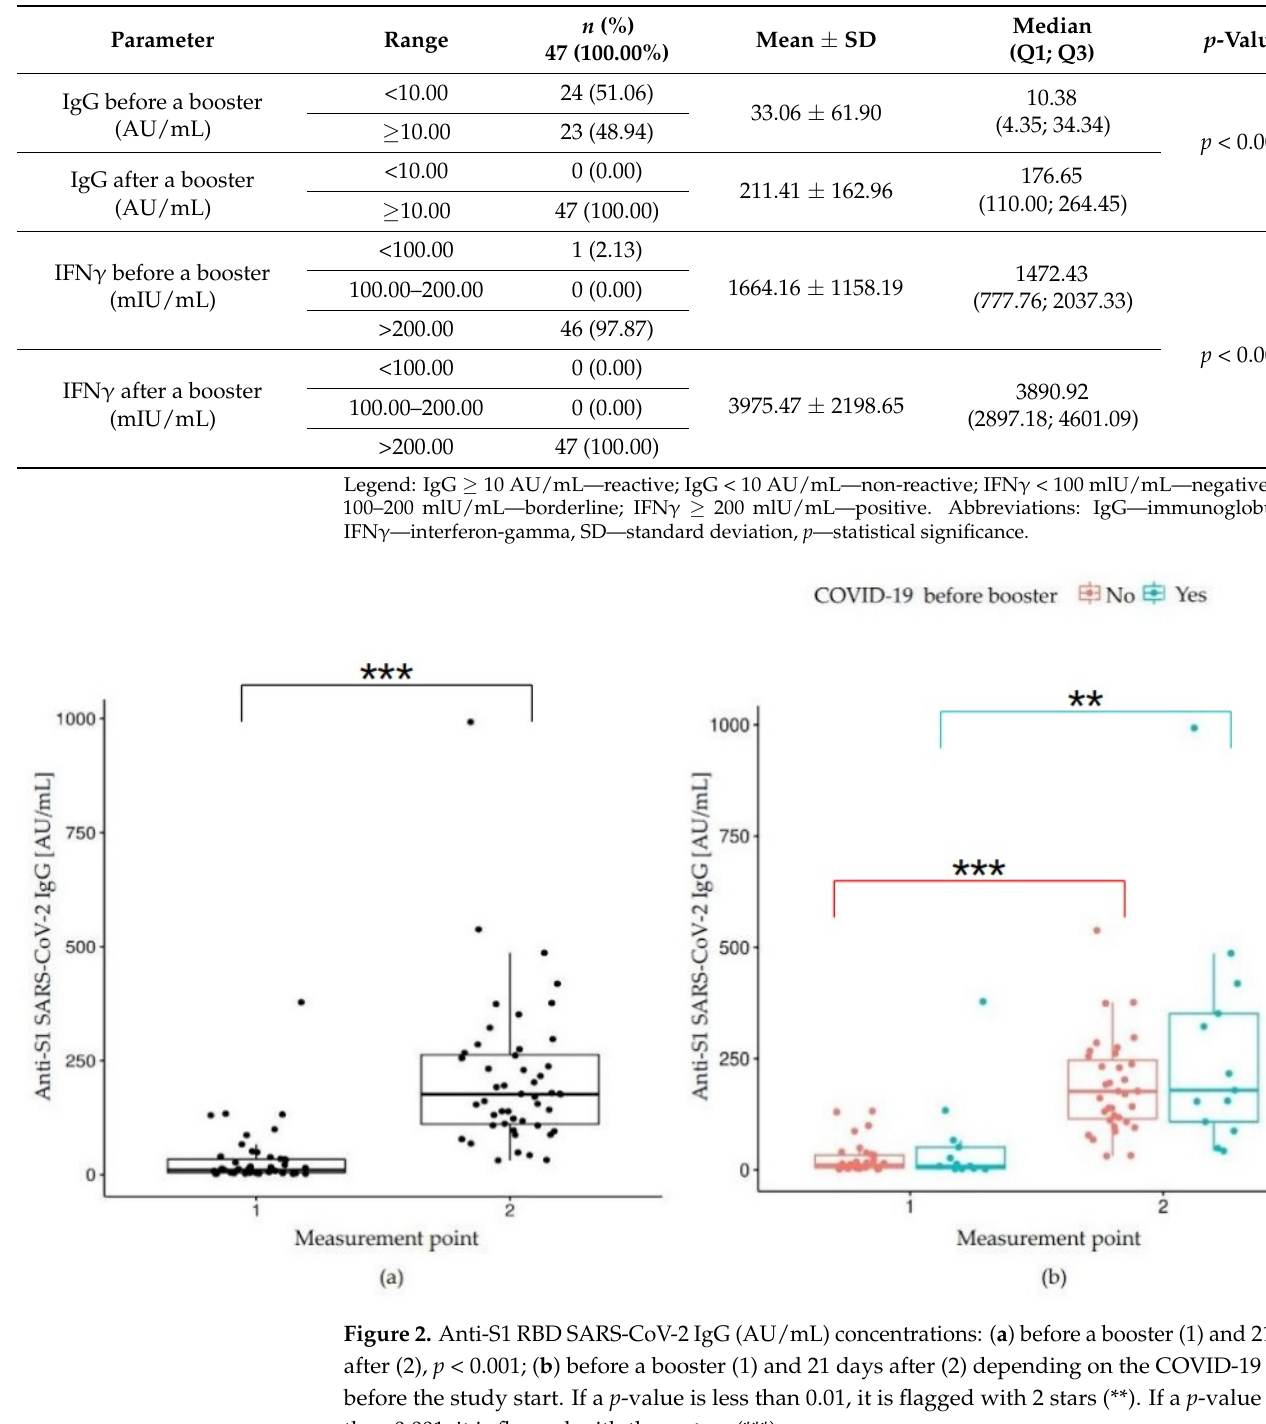
Table 2. Anti-SARS-CoV-2 IgG (CLIA-measured) and IFN γ concentrations (IGRA-measured) in the homologous (ChAd/ChAd) recipients before and after receiving a BNT booster.